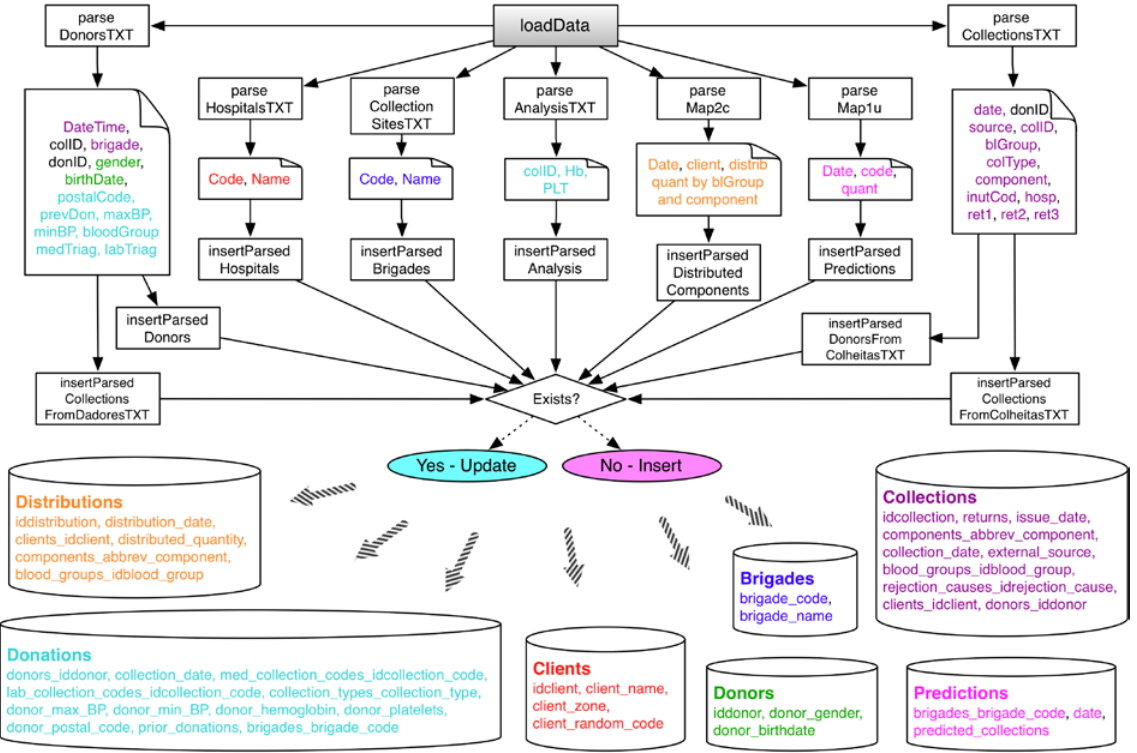
Figure 3: SAD_BaSe information flow. Several files are exported from the blood bank software, the file content is parsed and the obtained information inserted/updated into SAD_BaSe.